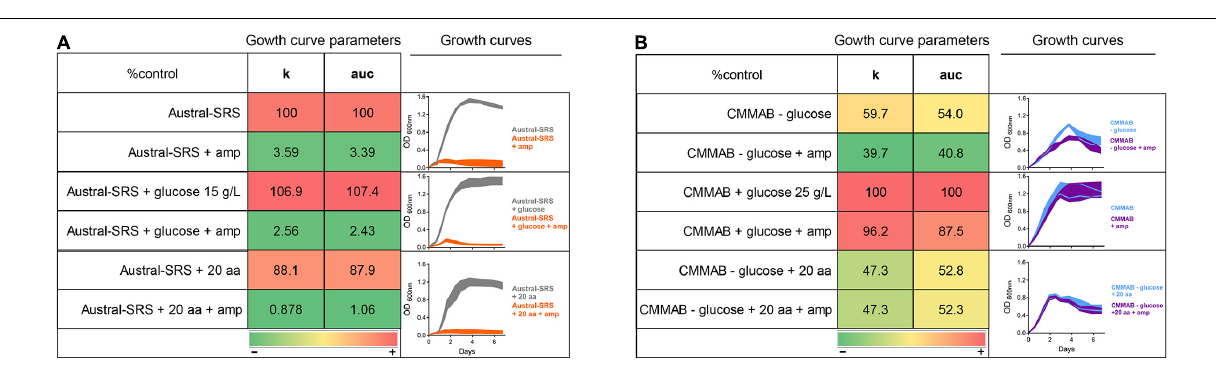
FIGURE 6 | Effect of glucose and amino acid supplements in amp resistance. P. salmonis LF-89 growth curves and curve parameters (carrying capacity k and area under the curve auc) in Austral-SRS nutrient medium (A) and the optimized defined medium CMMAB (B) with or without glucose and amino acid supplements and their effect in bacterial resistance to amp. Note that “20 aa” refers to the mixture of amino acids used in the CMM1 composition, and in the case of CMMAB, they were added in addition to the amino acids present in the